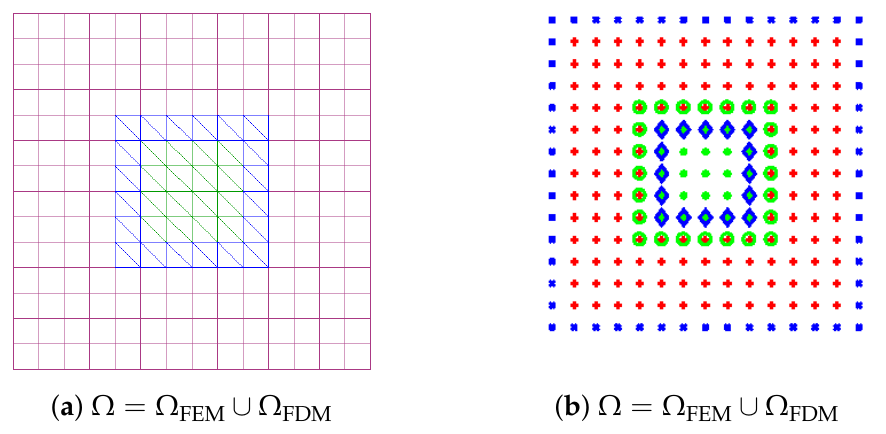
(blue diamonds), ω (green stars), ω + (cid:5) ∗